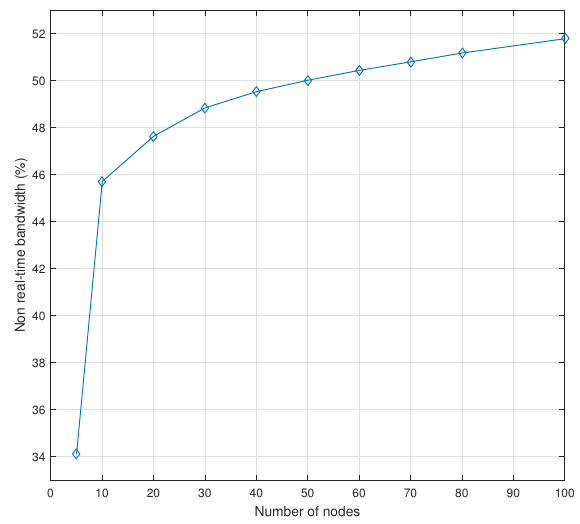
Figure 13. Non-real-time Bandwidth of AeroRing vs the network